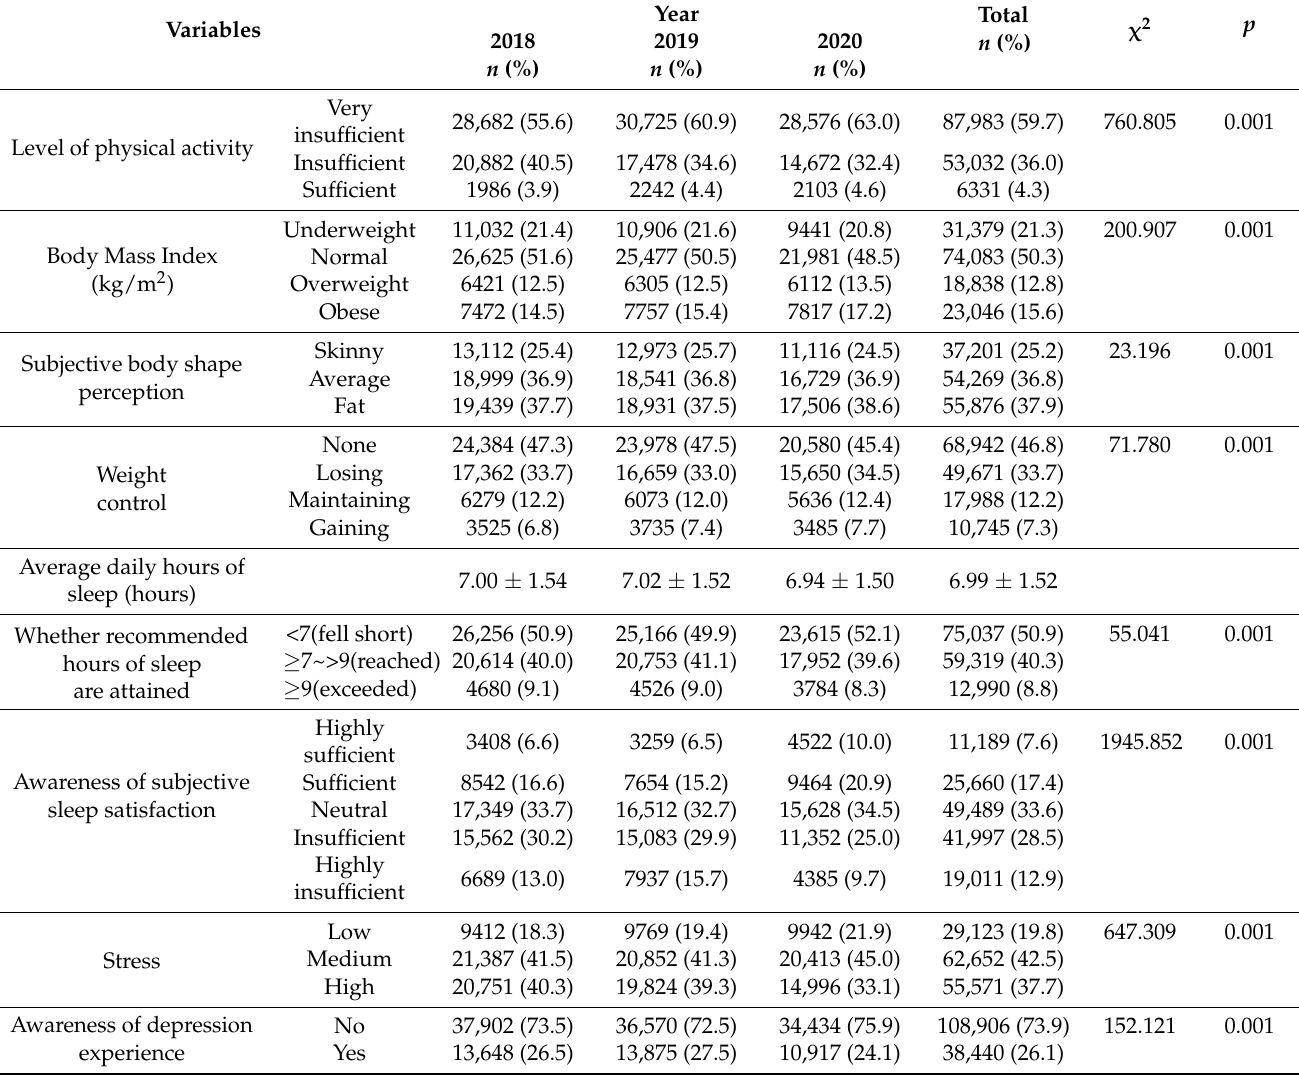
Table 2. The differences in physical activity, obesity, sleep, and mental health by year before and after